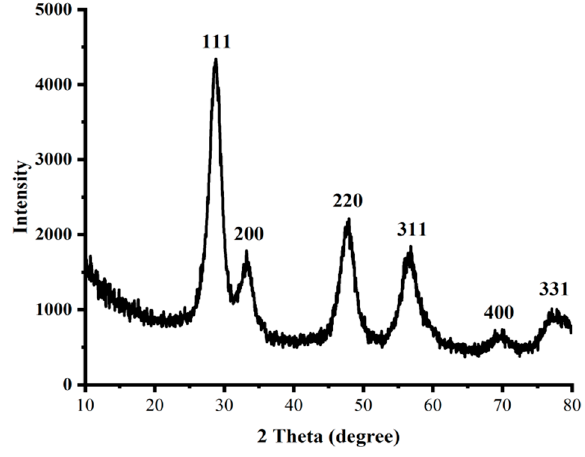
Figure 2. XRD analysis of the prepared Co-CeO 2 /C nanocomposite.